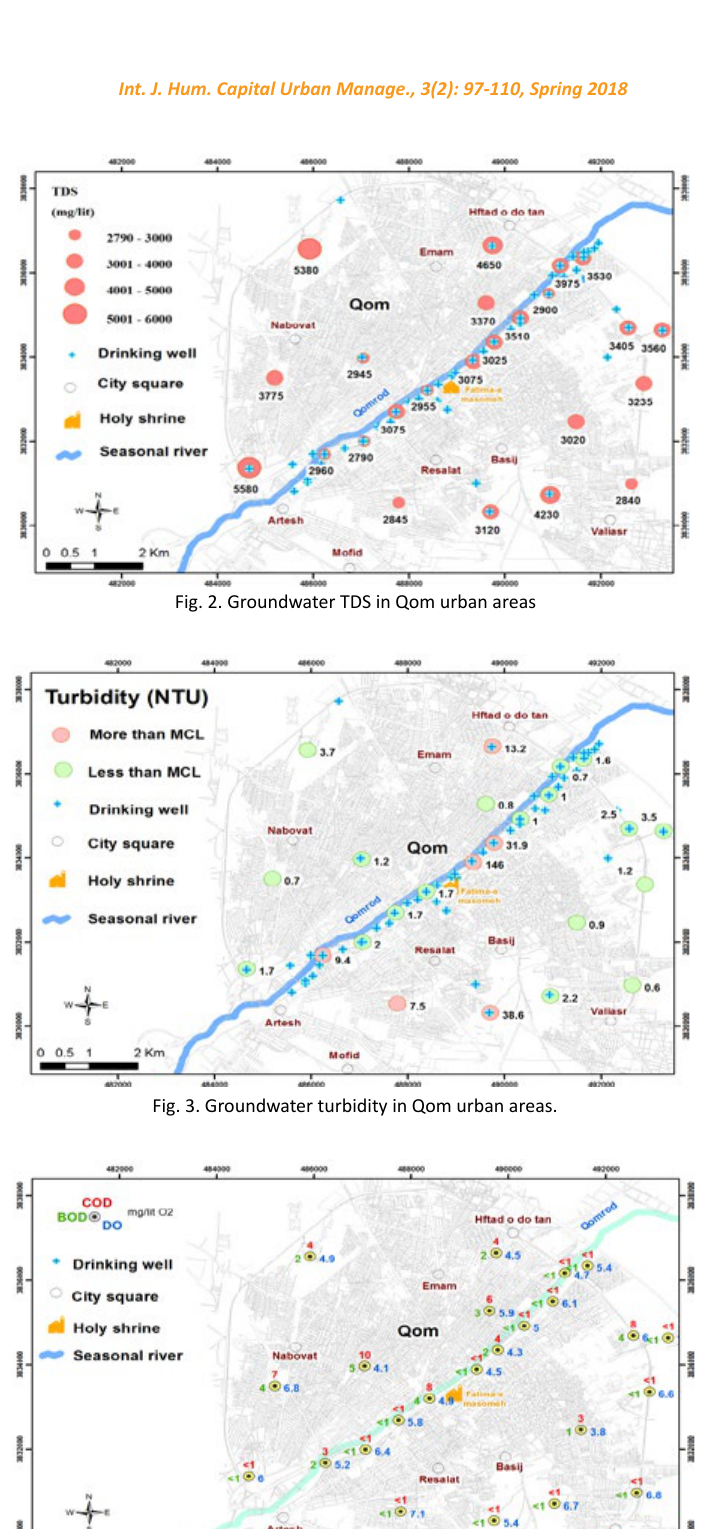
Fig. 4. DO, BOD and COD concentration of groundwater in Qom urban